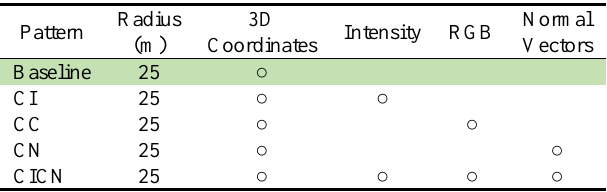
Table 3. Different features for comparison.